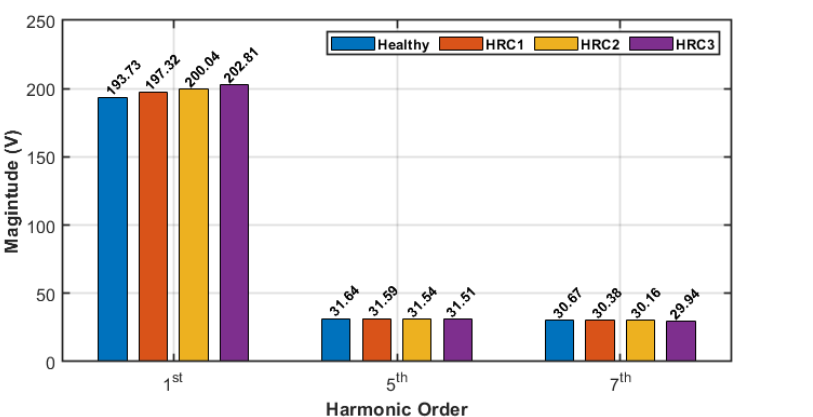
Figure 11. Variations in the harmonic content of stator voltage spectrum for healthy and faulty machine under HRC fault in FOC drive.